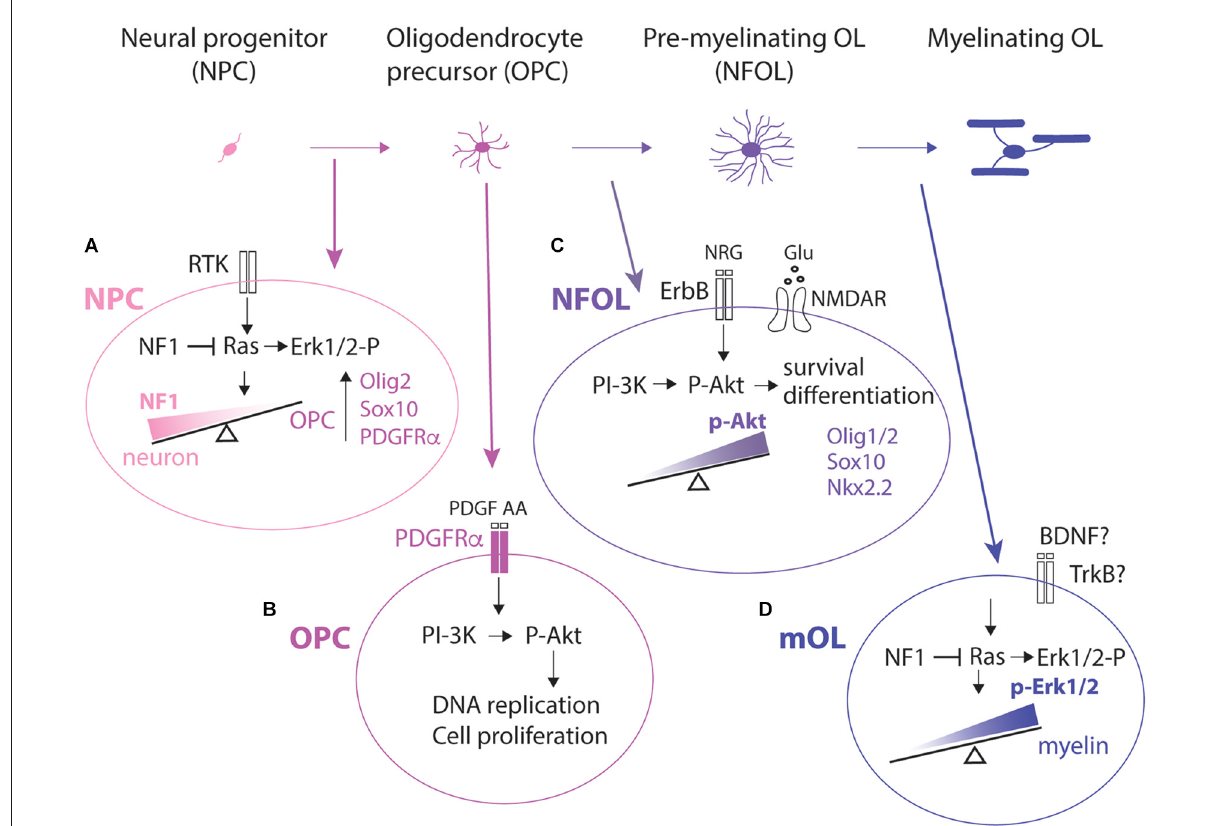
FIGURE1 Lineage progression from an NPC to a myelinating OL and examples of key signaling pathways at each stage. (A) : NPC. OPCs are specified from NPCs in the ventricular and subventricular zones. Reduction in NF1 leading to enhanced activation of Ras-Mapk-Erk1/2 pathway shifts the fate of NPCs to an OPC fate and suppresses the neuronal fate. Committed OPCs upregulate Olig2 and Sox10 which in turn turns on Pdgfra transcription. (B) : OPC. OPC proliferation is dependent on PDGFR α and is mediated by PI-3K activating Akt and not through Mapk activating Erk1/2. (C) : NFOL. In NFOLs, PI-3K activating Akt is primarily responsible for their terminal differentiation, survival, and initiation of myelination, possibly via the transcription factor FoxO1. HDAC1/2 activity, Myrf, and upregulation of Sox10, and Nkx2.2 are also critical for terminal differentiation. (D) : mOL. In myelinating OLs (mOLs), activation of the Ras-Erk1/2 pathway is critical for maintaining myelination. NF1, neurofibromin; RTK, receptor tyrosine kinase; Erk1/2-P, phosphorylated Erk1/2; PDGF, platelet-derived growth factor; PDGFR α , platelet-derived growth factor receptor alpha; PI-3K, phosphatidyl inositol-3-kinase; P-Akt, phospho-Akt; BDNF, brain-derived neurotrophic factor; NFOL, newly formed OLs; HDAC1/2, histone deacetylase 1 and 2; Myrf, myelin regulatory factor; NRG,